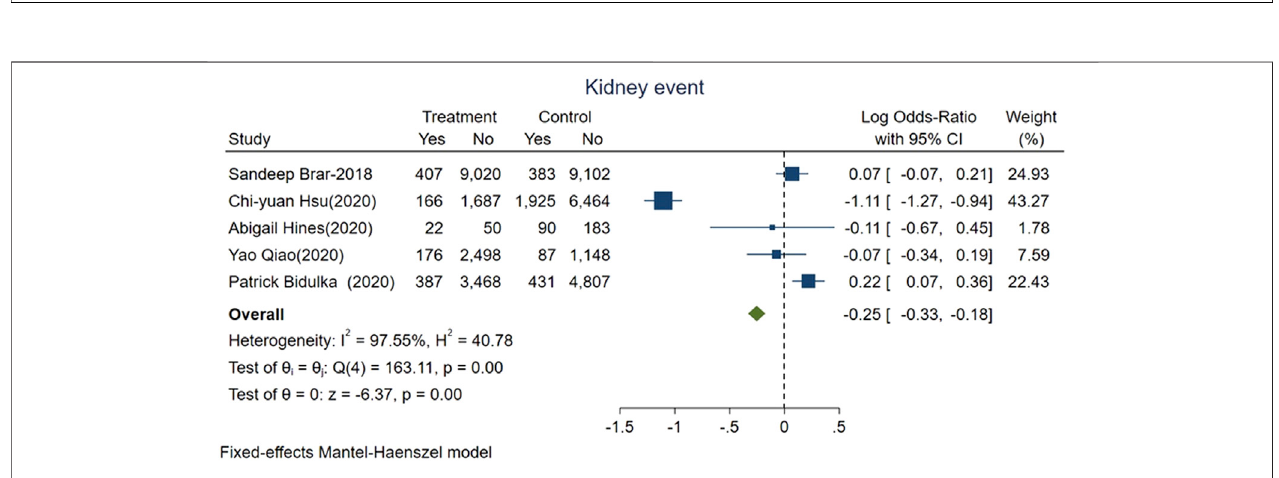
FIGURE3| ForestplotshowingreducedriskofadversekidneyeventscomparingACEi/ARBusersvs.nonusersafterAKI.FixedeffectsofMantel-Haenszelmodel.